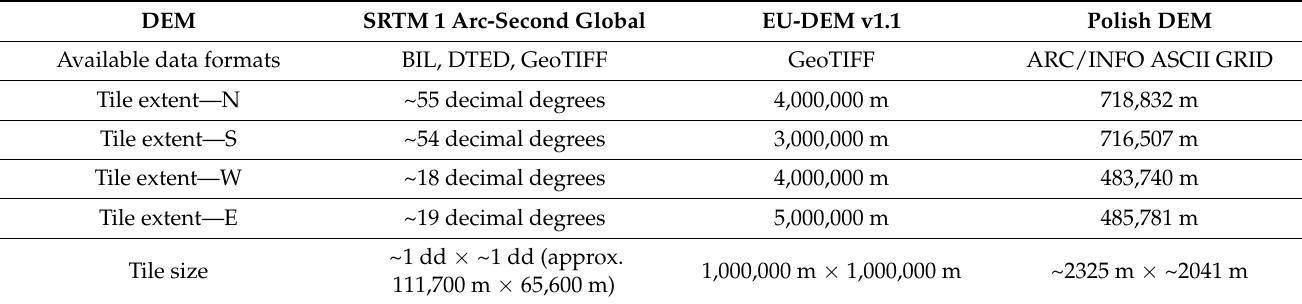
Table 4. Full technical specifications of the selected DEMs. Source: own elaboration, on the basis of USGS [54], Copernicus Land Monitoring Service [55], and Polish DEM—Geoportal [57].